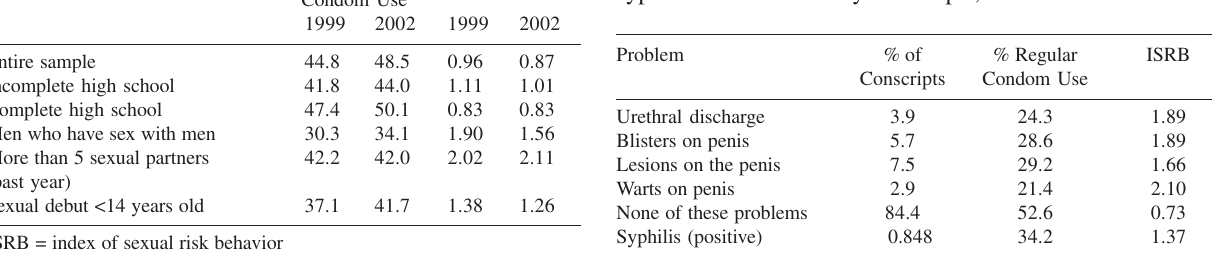
Table 3 - Percentage (%) of regular condom use and index of sexual risk behavior (ISRB) by population subgroups and year. Brazilian Army conscripts, 1999 and 2002 Subgroup % Regular